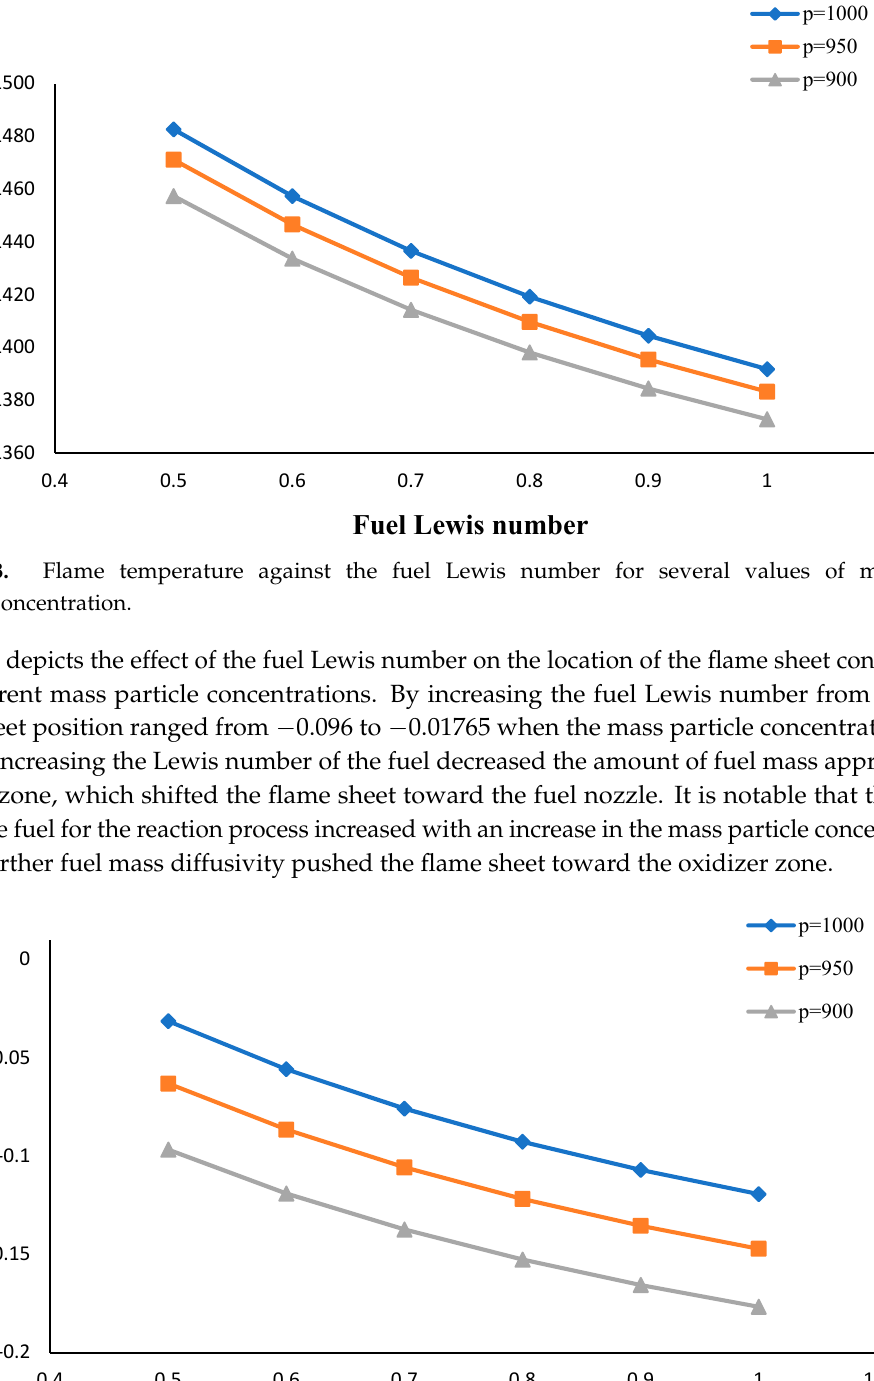
Figure 9. Flame sheet position against the fuel Lewis number for different mass particle concentrations.